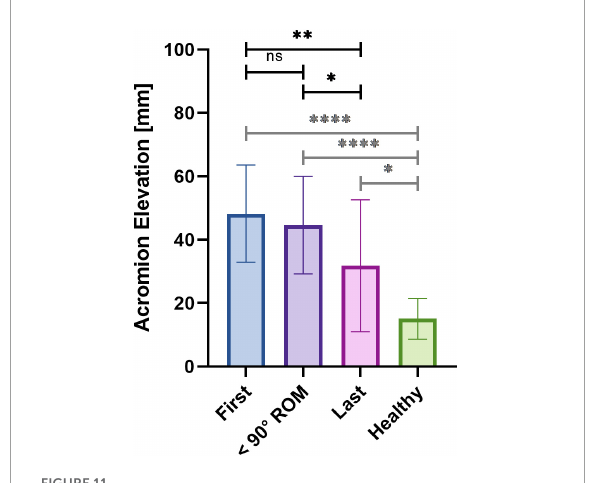
ROM and the last three sessions of patients, and of healthy